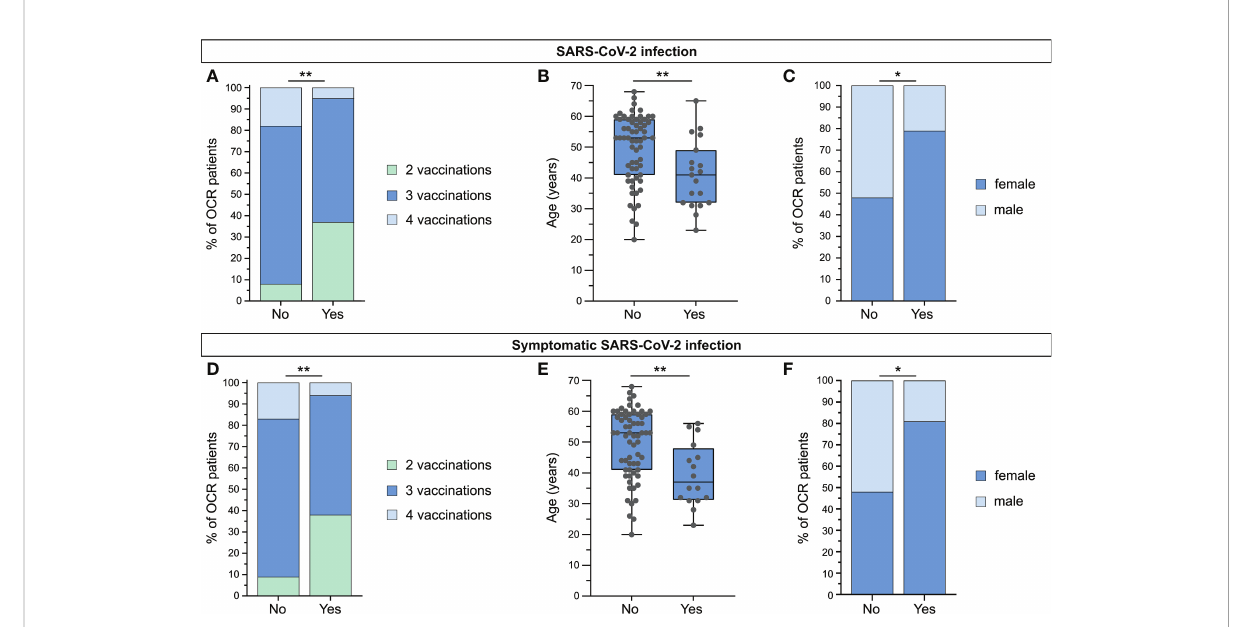
FIGURE 3 Vaccine-based clinical protection of MS patients receiving ocrelizumab. (A) Differences in vaccine doses between OCR-pwMS infected with SARS-CoV-2 and non-infected patients; (B) Comparison of age between SARS-CoV-2-infected OCR-pwMS and non-infected patients. (C) Differences in sex between non-infected and infected OCR-pwMS; (D) Comparison of vaccine doses between OCR-pwMS with and without symptomatic SARS-CoV-2 infection; (E) Differences in age between OCR-pwMS with and without symptomatic SARS-CoV-2 infection; (F) Differences in sex between OCR-pwMS with and without symptomatic SARS-CoV-2 infection. *p ≤ 0.05, **p ≤ 0.01. OCR, ocrelizumab; SARS-CoV-2, severe acute respiratory